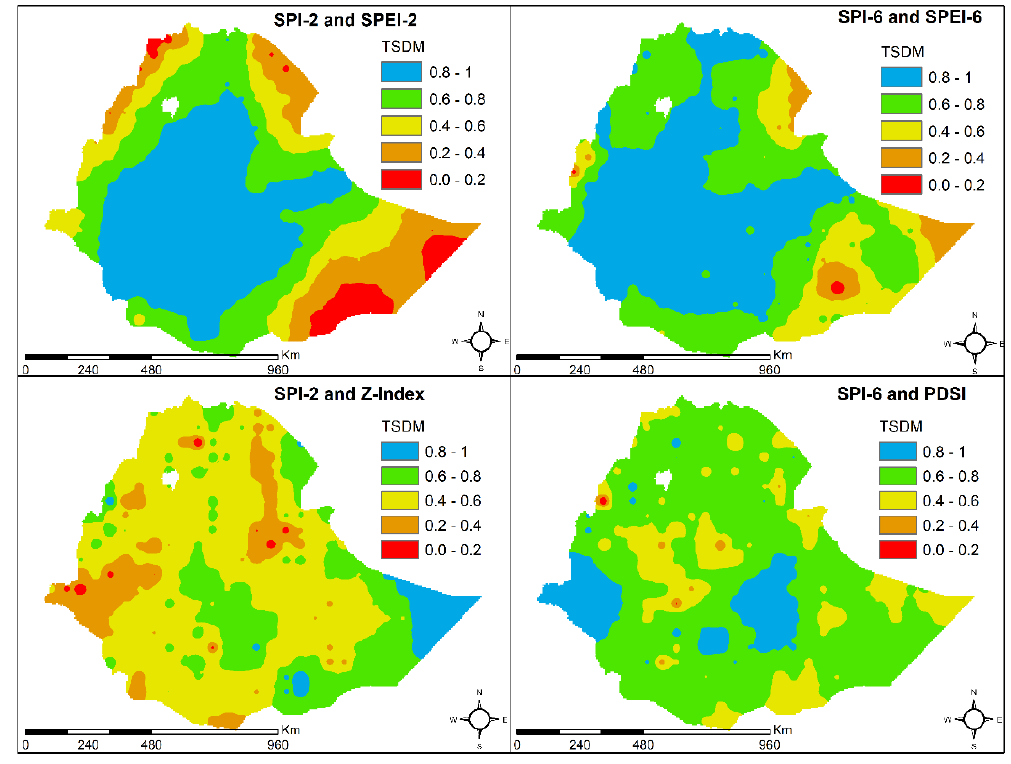
Figure 3. Normalized Time Series Distance Measure (TSDM) between agricultural and meteorological indicators.